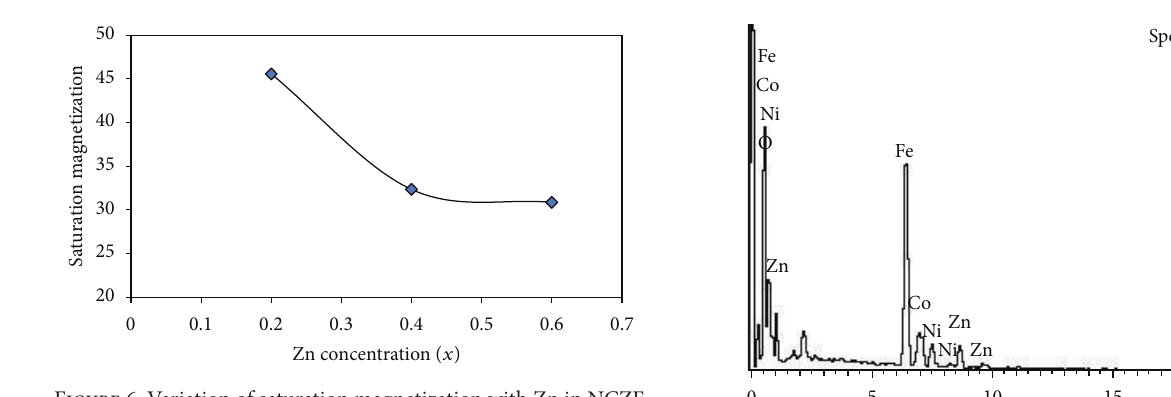
Figure 6: Variation of saturation magnetization with Zn in NCZF.